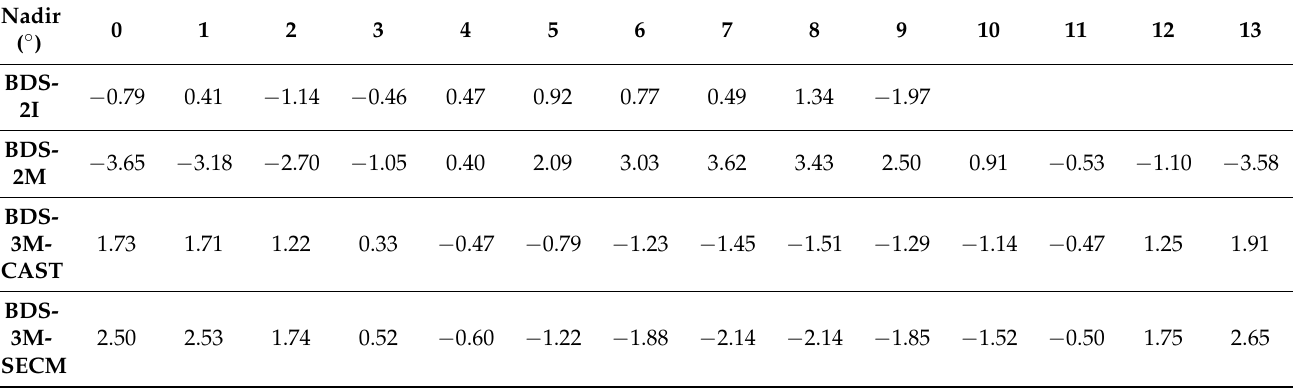
Figure 5. The satellite-specific and satellite-block-specific PCV values for BDS-2 IGSO, BDS-2 MEO, BDS-3 CAST MEO, and BDS-3 SECM MEO. Table 4. Estimated satellite-block-specific PCVs for BDS IGSO and MEO satellites. (unit: mm).